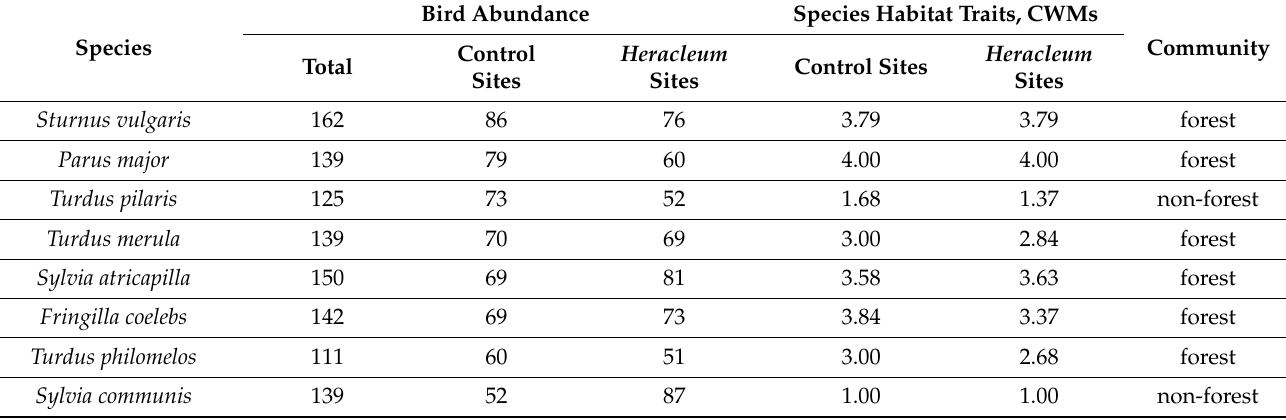
Table A1. List of 70 bird species observed during research on N = 38 sites that were sorted into two communities. Species habitat traits were the community-level weighted trait values, CWMs, reflecting functional diversity (see Section 2.4. Data analyses). The blue color indicates which species might have been responsible for the functional diversity of the forest bird community, while the red color applies to non-forest birds in the same